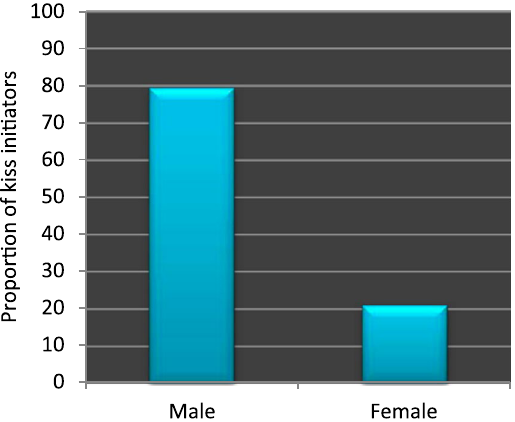
Figure 1. Proportions of males and females initiating a kiss.